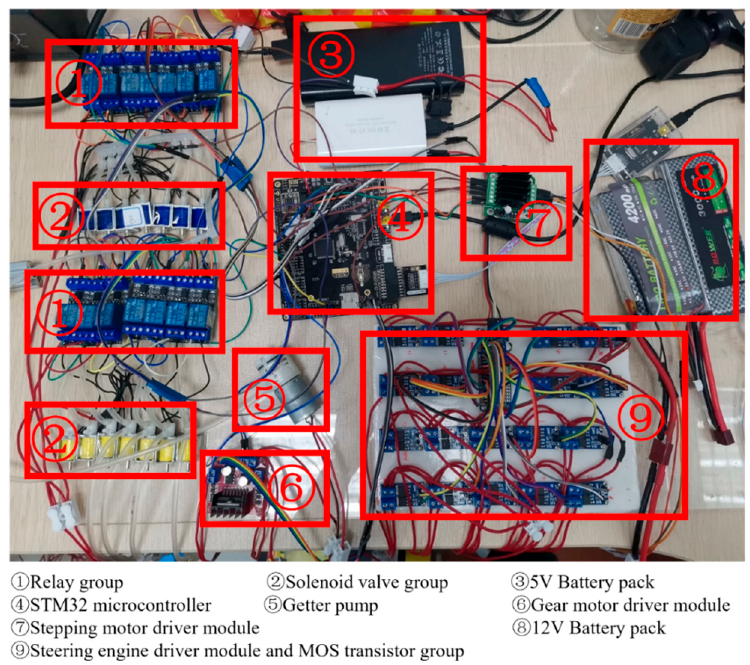
Figure 11. ISB-MWCR real machine test hardware system diagram.